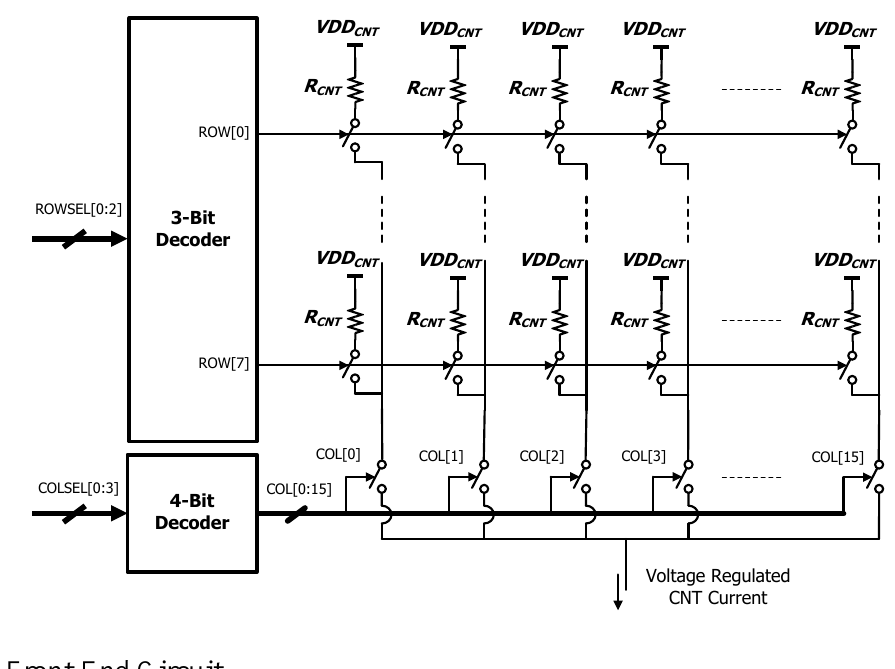
Figure 5. Circuit schematic for CNT sensor array. Individual CNT cells can be measured via the 3 bit row decoder and 4 bit column